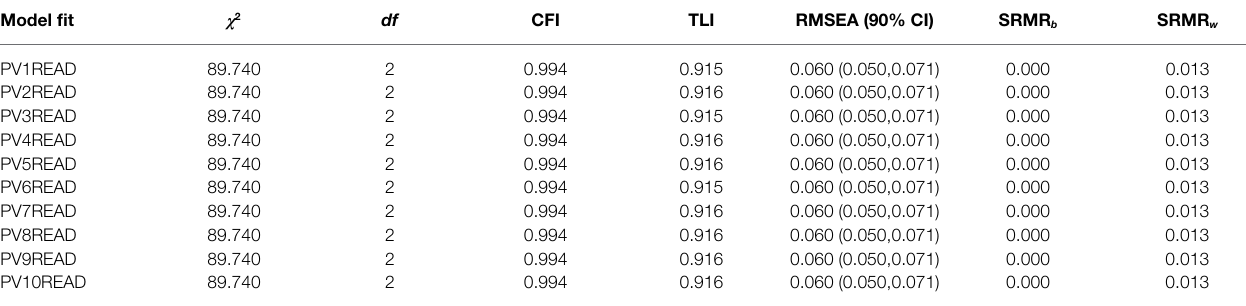
TABLE 3 | Fit indices for Model 1 . Model fit